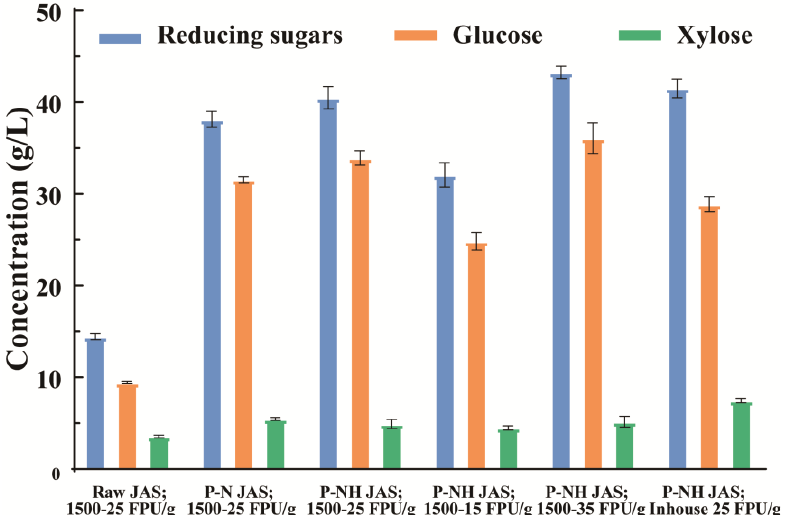
Figure 3. Sugar analysis of the enzymatic hydrolysates (5% substrate concentration, w / v ; 50 °C; pH 4.8; 48 h) from raw and pretreated JAS using two enzyme combinations. P-N JAS: NaOH-pretreated JAS, P-NH JAS: CO-pretreated JAS; 1500: Accellerase ® 1500, 1110: in-house cellulase.